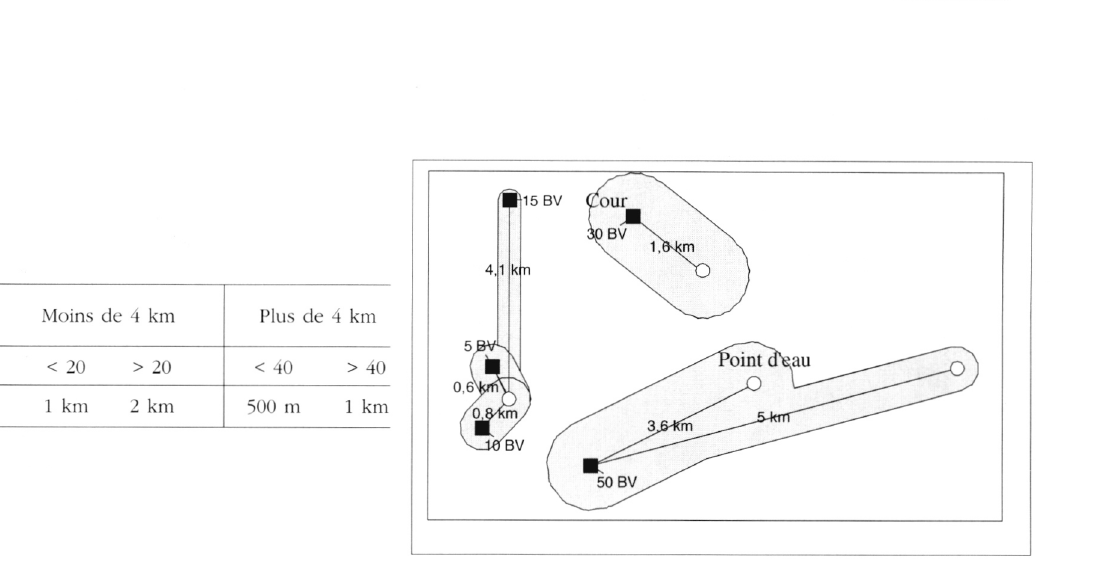
Fig. 17. - Polygones de zone d’influence des bovins entre la concession et le point d’abreuvement de fin de saison sèche (Michel et al., 1999).